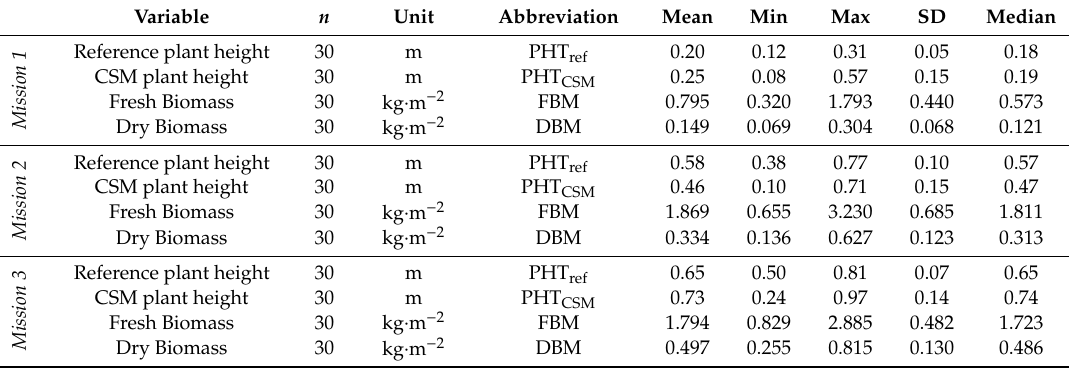
Table 2. Descriptive statistics of the crop parameters measured at the sample plots for M1, M2, and M3. n = number of samples; SD = standard deviation.